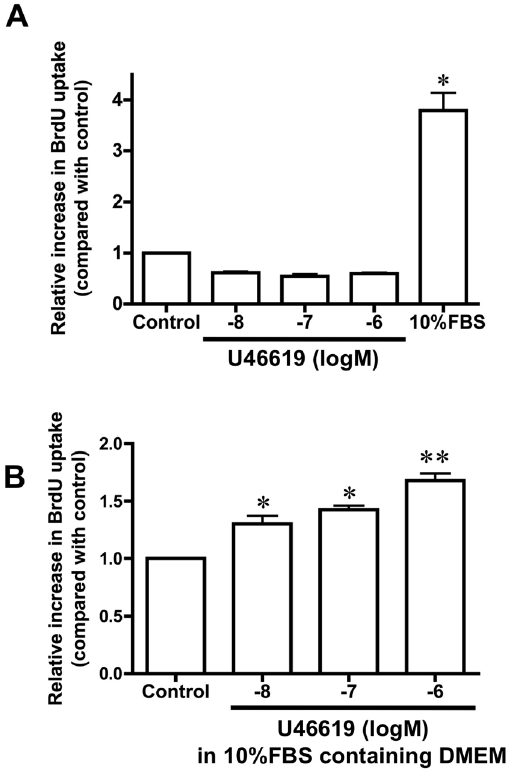
Figure 4. TP stimulation increased the DA SMC proliferative properties. TP stimulation caused DA SMC proliferation in the presence of FBS DMEM but not in the absence of FBS. (A) In the absence of FBS, the TP agonist did not seem to promote DA SMC proliferation. (B) In the presence of FBS, TP stimulation induced DA SMCs proliferation in a dose-dependent manner. Values are expressed as the mean 6 SEM. n=3 , 4. * and **indicate p , 0.01 and p , 0.001 versus control,